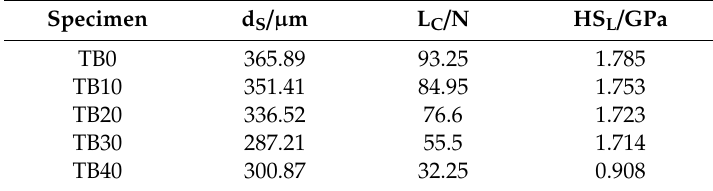
Figure 11. ( a ) Scratch morphologies and ( b ) acoustic emission signals of coatings with di ff erent TiB 2 particles content. Table 5. Results of the scratch test of coatings with di ff erent TiB 2 particles